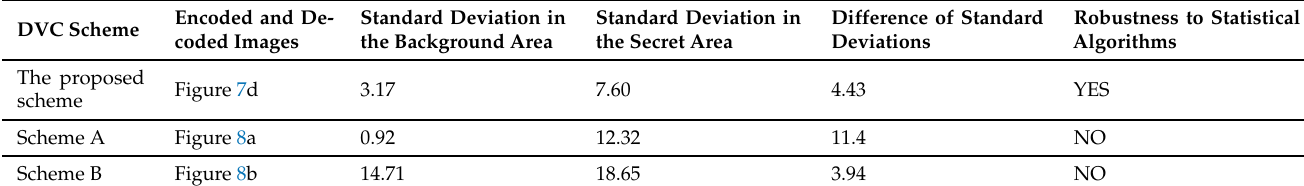
Table 1. The comparison of the proposed scheme with classical DVC schemes (the DVC scheme based on harmonic moiré gratings (Scheme A), and the DVC scheme based on dichotomous moiré gratings (Scheme